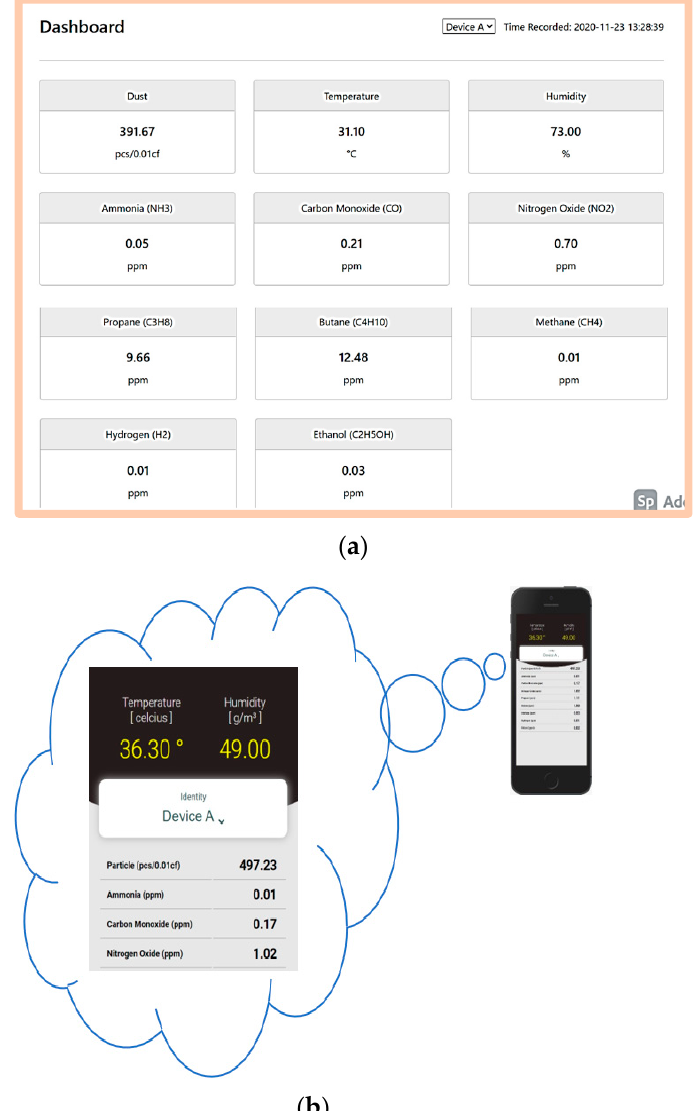
Figure 10. Wireless Outdoor Individual Exposure Indicator System display on different platforms. ( a ) Display on a website. ( b ) Display on smartphone application.